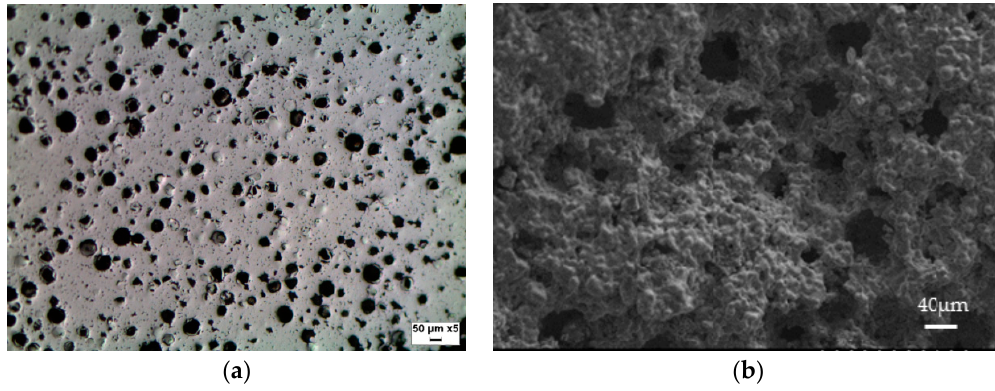
Figure 13. Optical photograph ( a ) and Scanning Electron Microscope (SEM) photograph ( b ) showing the cross-section of the sintered part with 30 vol % of polymethyl methacrylate (PMMA).